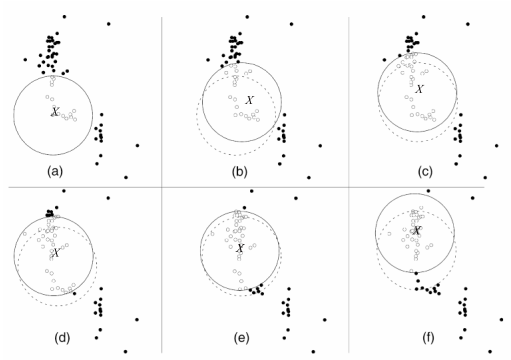
Fig. 3 Process for identifying significant locations using cluster methods [43]